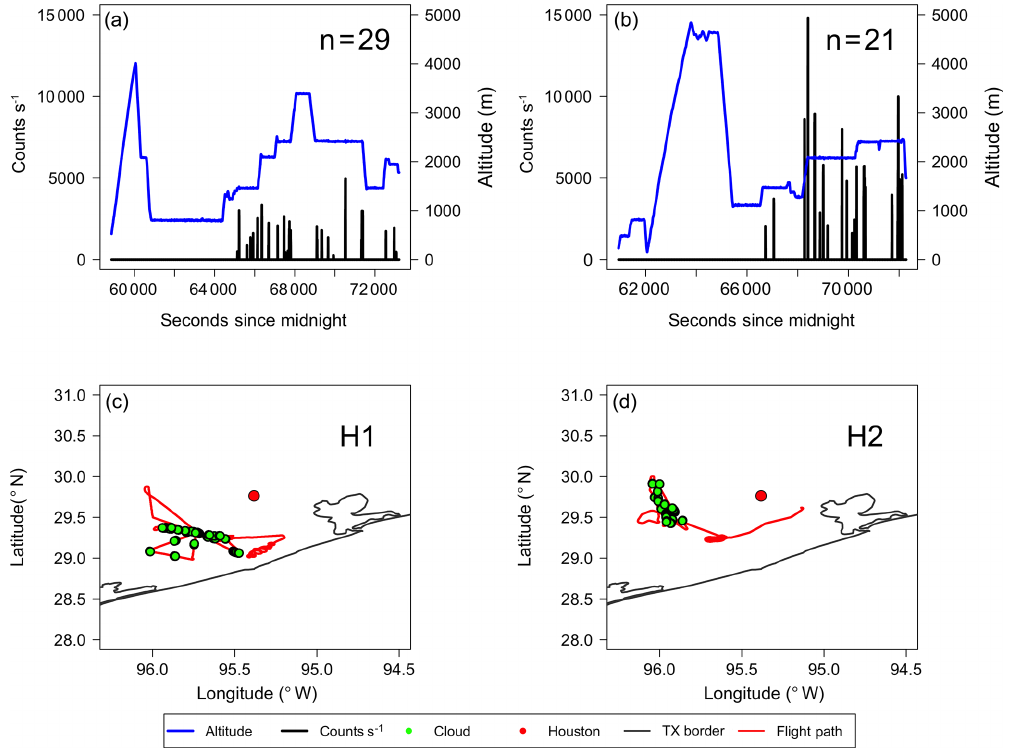
Figure 3. As in Fig. 2 but for H1 and H2.